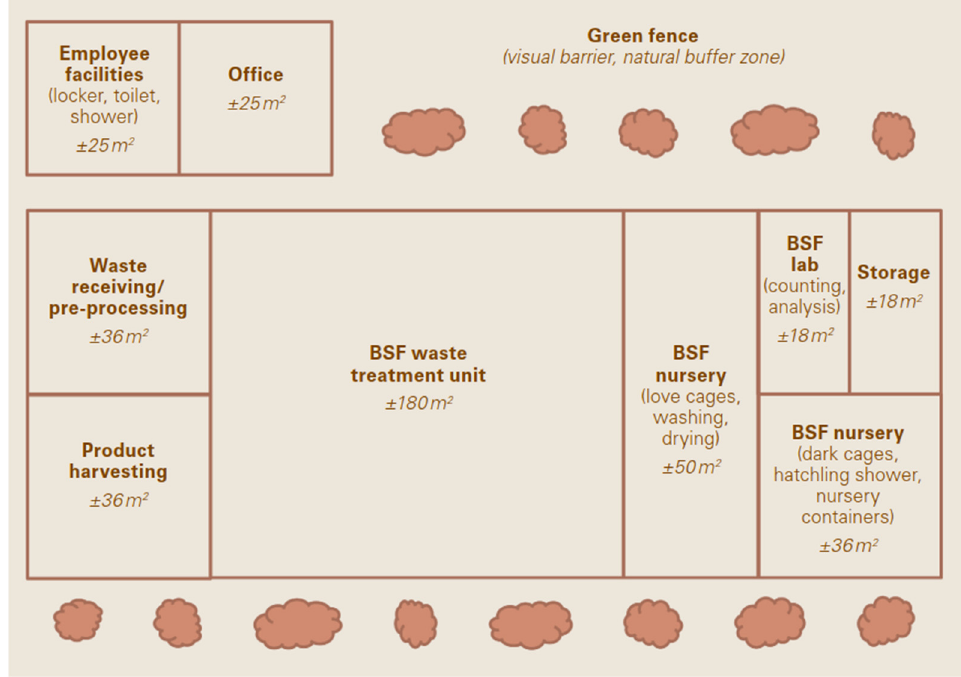
Figure 2. Draft of a BSFL farm and size estimation for the conversion of 2 tons of biowaste per day (from Dortmans et al. [121] (CC BY 4.0)).